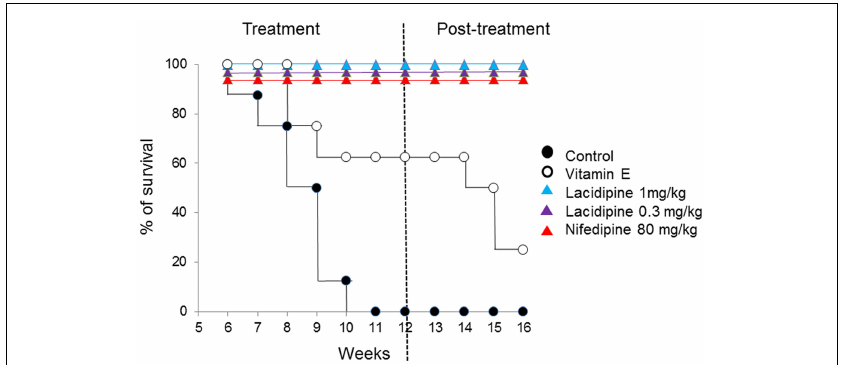
FIGURE 1 | Prolongation of survival in salt-loaded, stroke-prone spontaneously hypertensive rats (SHR-SP) with high mortality due to malignant hypertension by CCBs or vitamin E (redrawn from Napoli et al.,